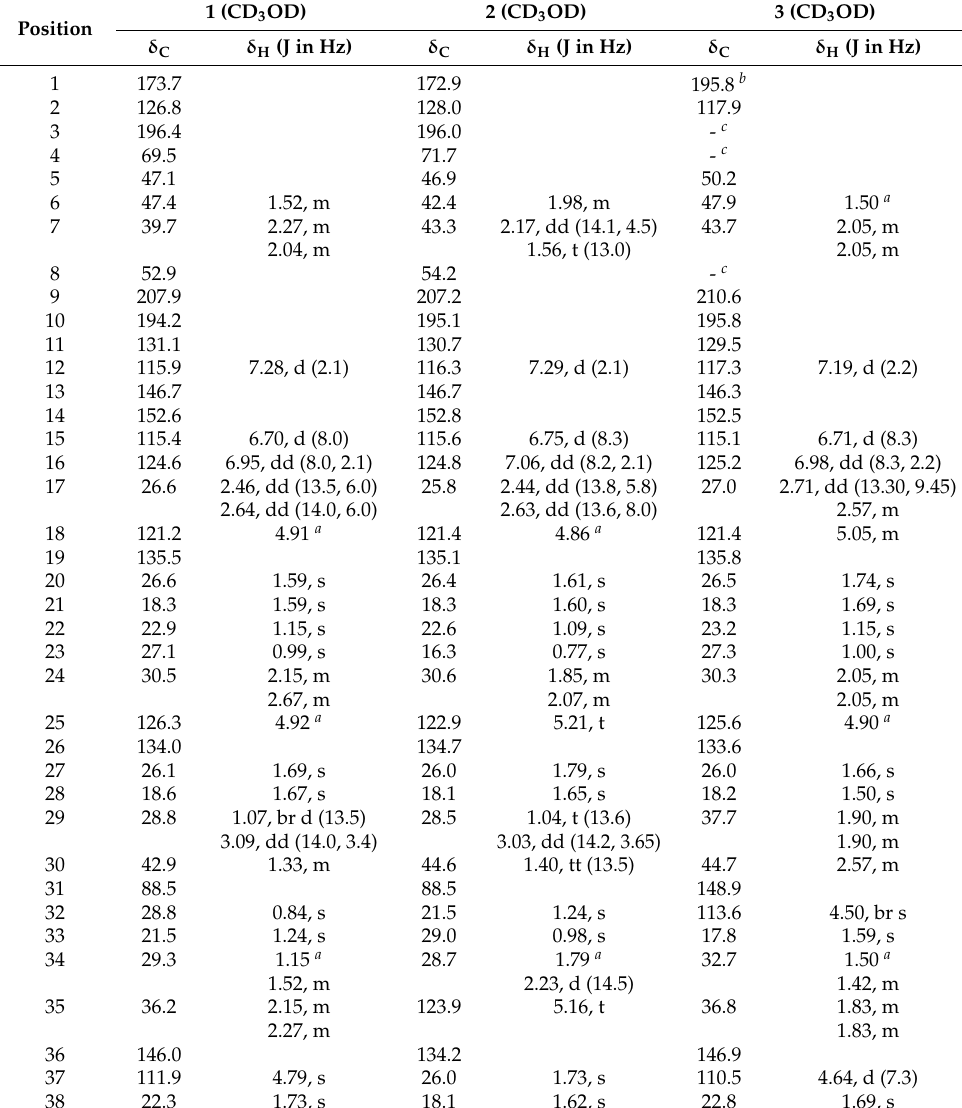
Table 1. 1 H (500 MHz) and 13 C (125 MHz) NMR spectroscopic data of Compounds 1 – 3 (in